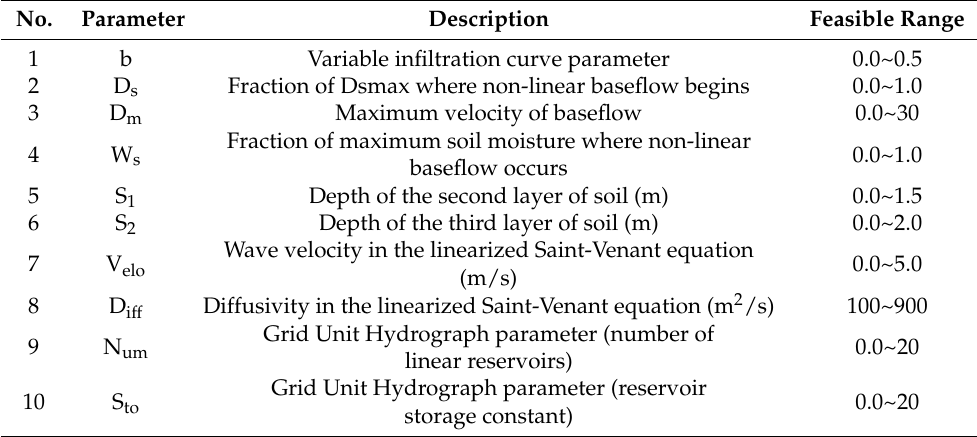
Table 2. Adjusted parameters of the VIC hydrological model in